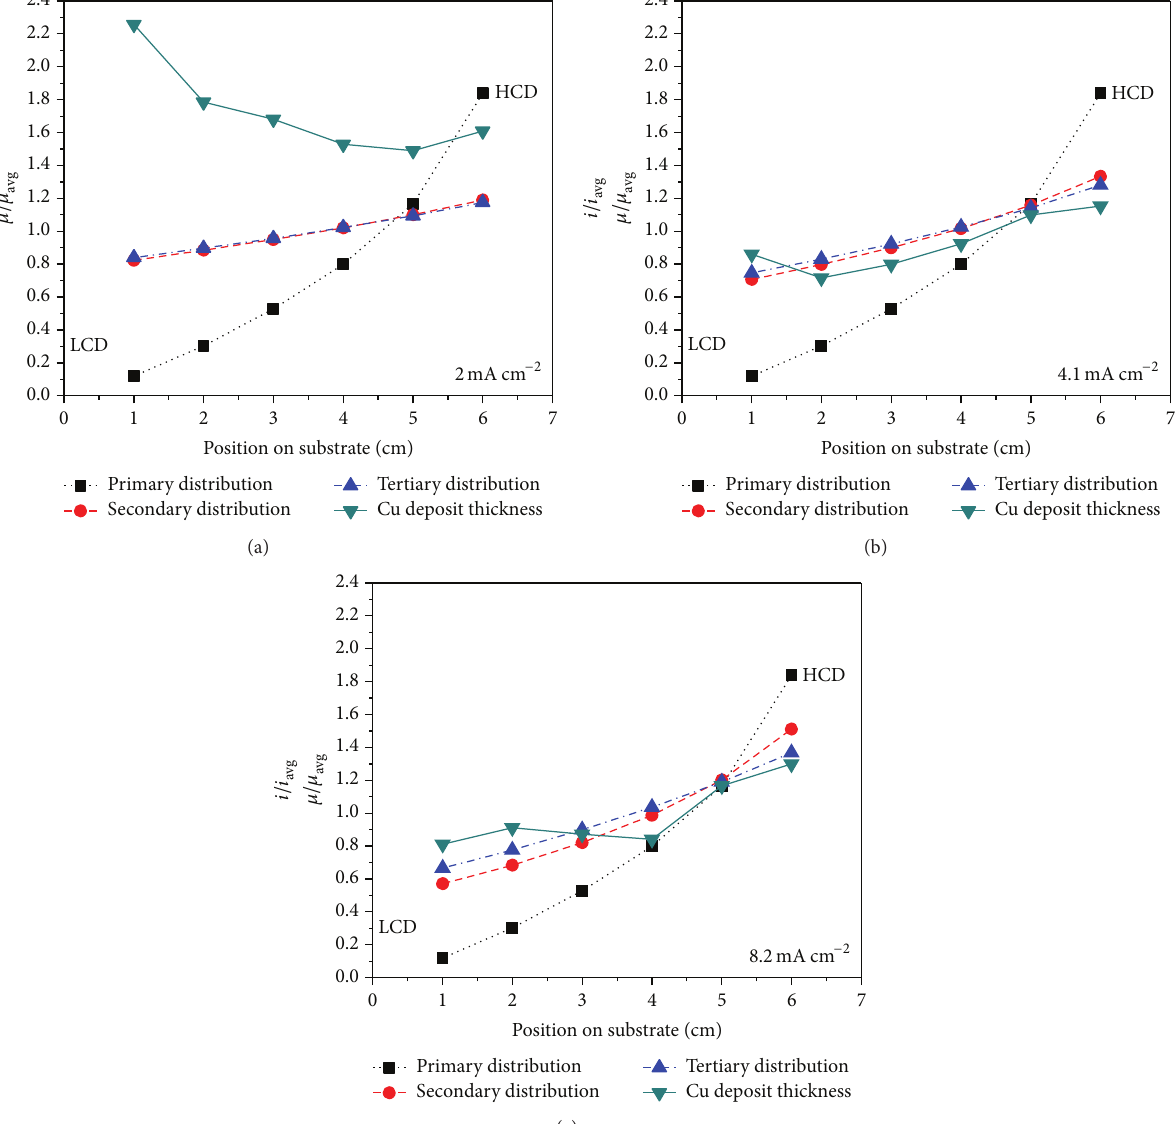
Figure 11: Comparison of experimental determined normalized deposit thickness distribution ( 𝜇/𝜇 secondary, and tertiary current distributions ( 𝑖/𝑖 current densities of (a) 2, (b) 4.1, and (c) 8.2 mAcm −2